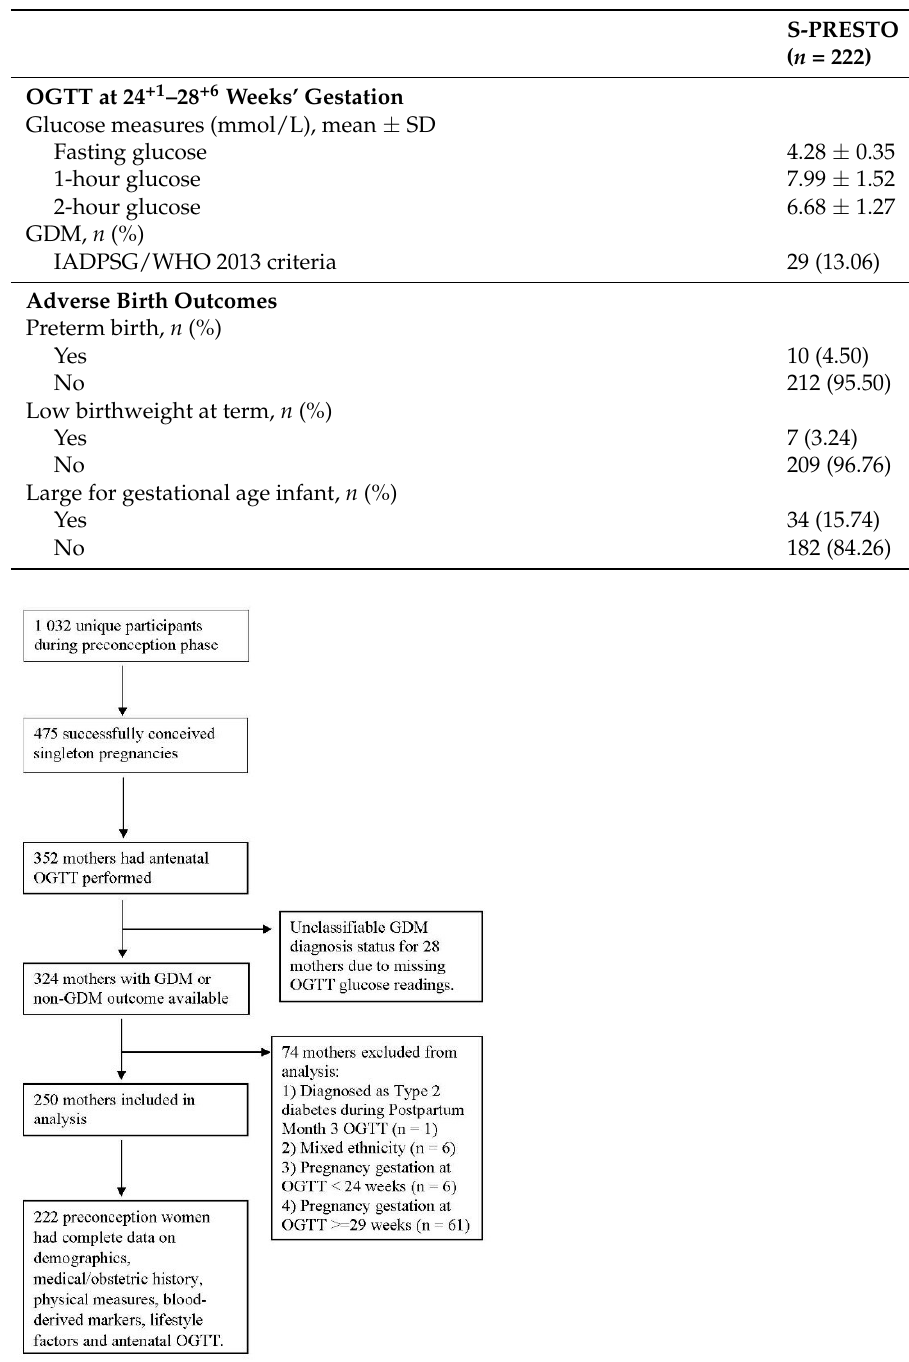
Figure 1. Sample Participant characteristics. Sample selection flowchart of 222 preconception women who had complete data on demographics, medical/obstetric history, physical measures, blood-derived markers, lifestyle factors and antenatal OGTT for machine learning models. Table 1. Participant characteristics at preconception baseline. Participant characteristics table on demographics, medical/obstetric history, physical measures, blood-derived markers, lifestyle fac- tors, metabolic indices, prediabetes status, antenatal OGTT and adverse birth outcomes. Continu- ous variables are presented as group mean value and standard deviation. Categorical variables are presented as count and percentage.